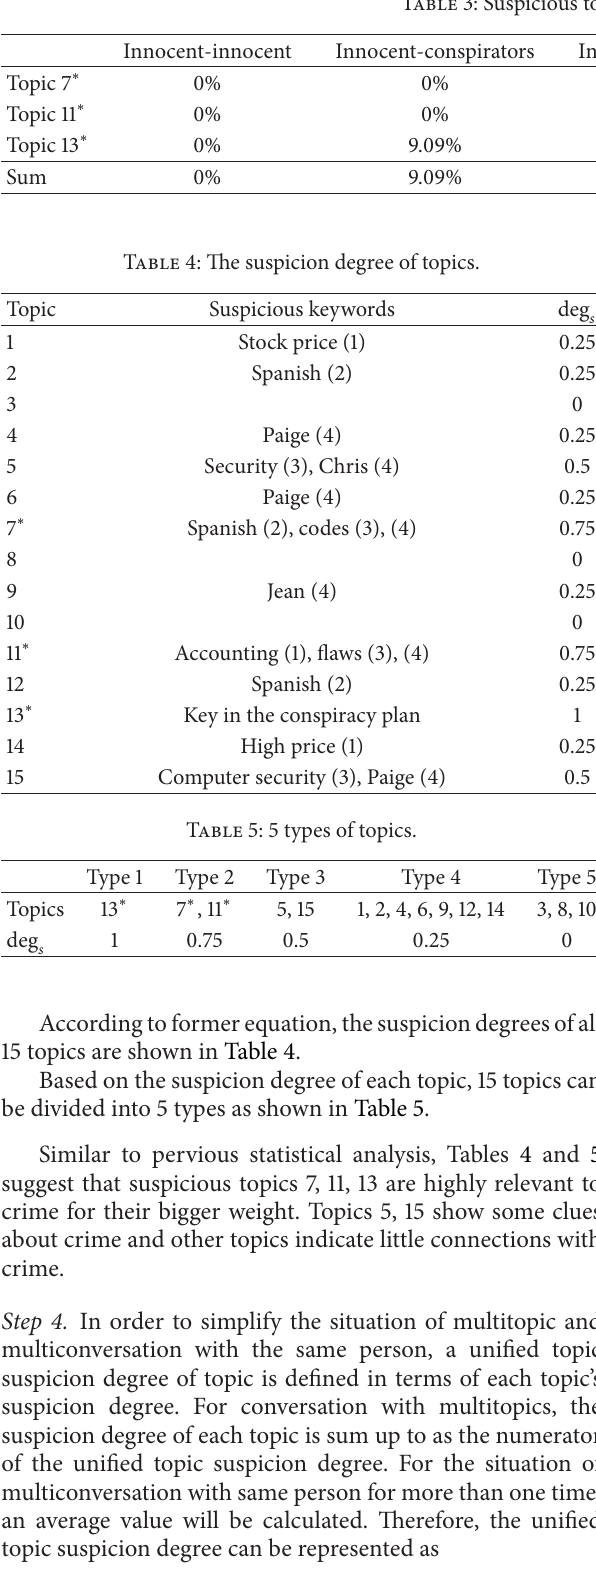
Table 3: Suspicious topics frequency comparison.